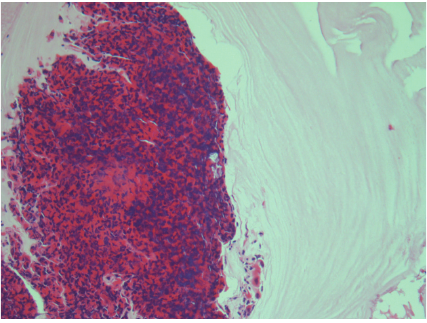
Figure 3: Aggregate of eosinophils with mucus. H & E × 200.